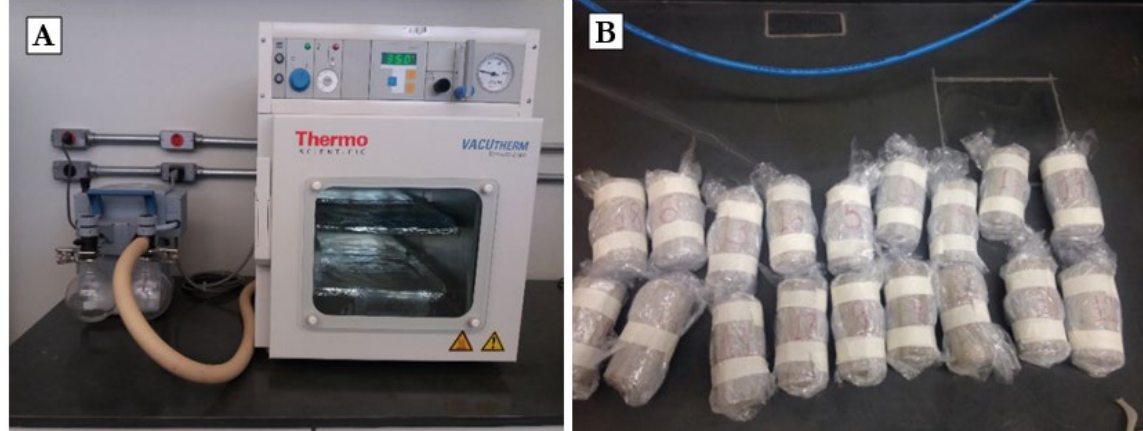
Figure 1. Stages of the precondition adopted: 1ª Stage - vacuum oven (A) and 2ª Stage – Samples packaged in a plastic film (B).